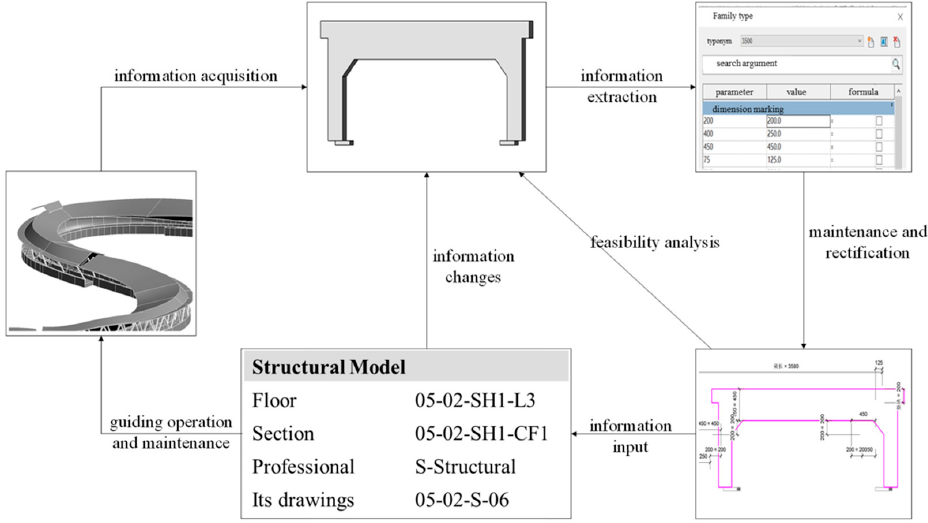
Figure 12. Intelligent O&M application system for building structure